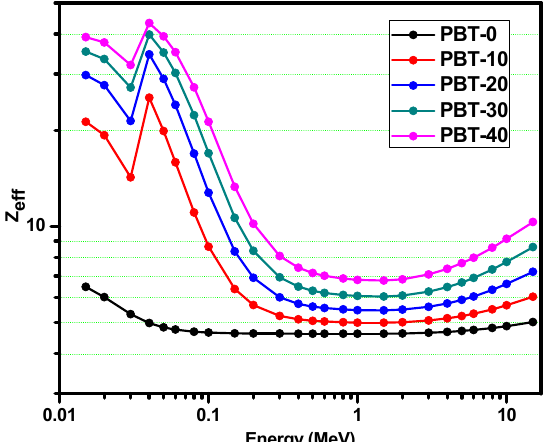
Figure 7. The effective atomic number (Z eff ) of the five investigated polymers.